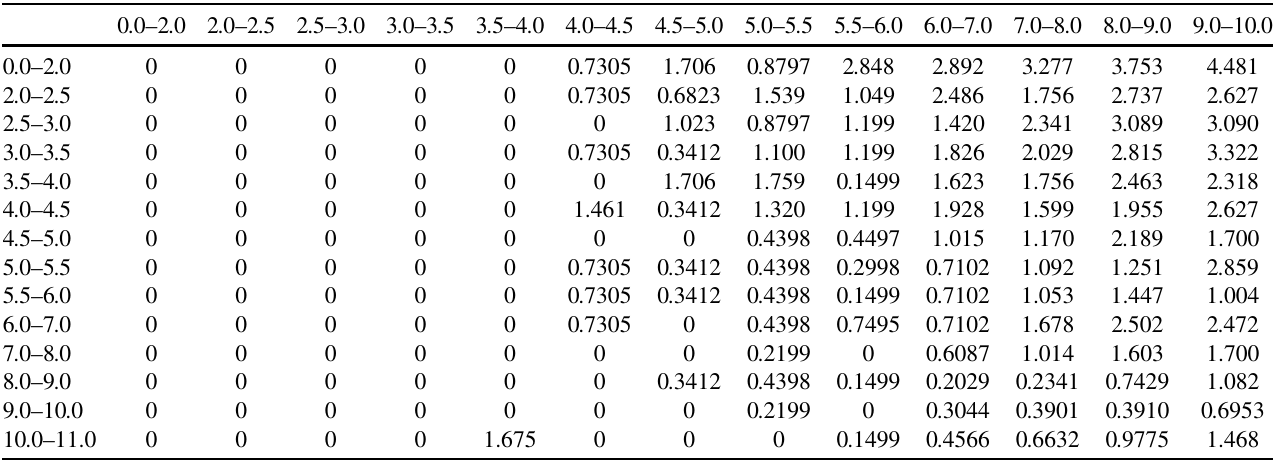
TABLE VI. (cid:4) þ background from (cid:3) (cid:5) CC events (all values (cid:2) 10 (cid:1) 4